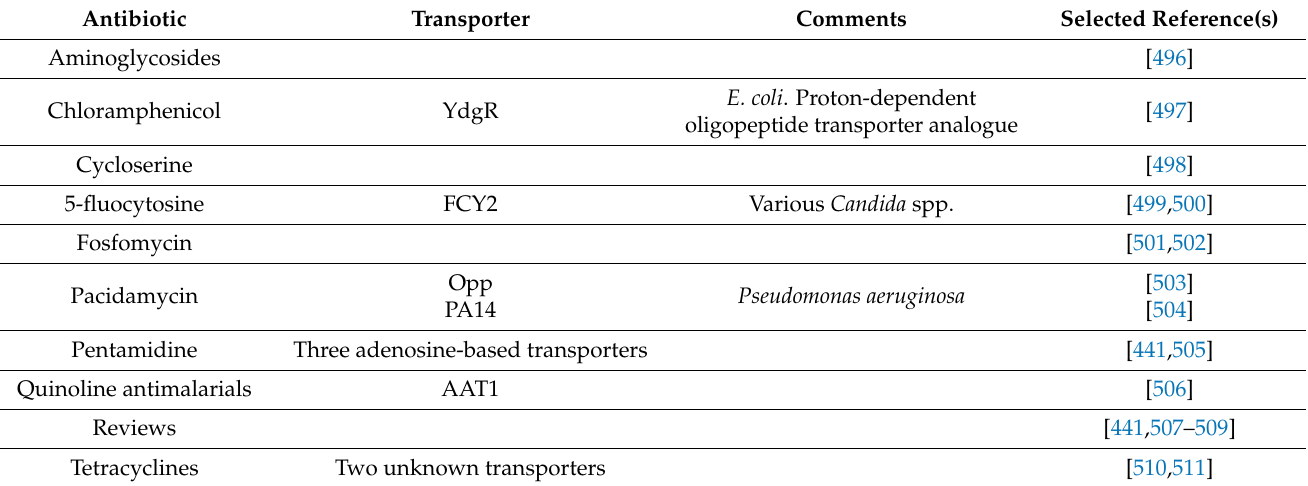
Table 1. Some examples of differential resistance to anti-microbial drugs involving uptake transporters. Antibiotic